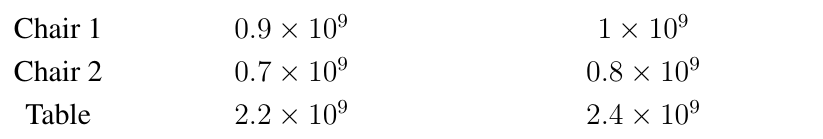
Table 1. Range to detect objects. Correlation values.